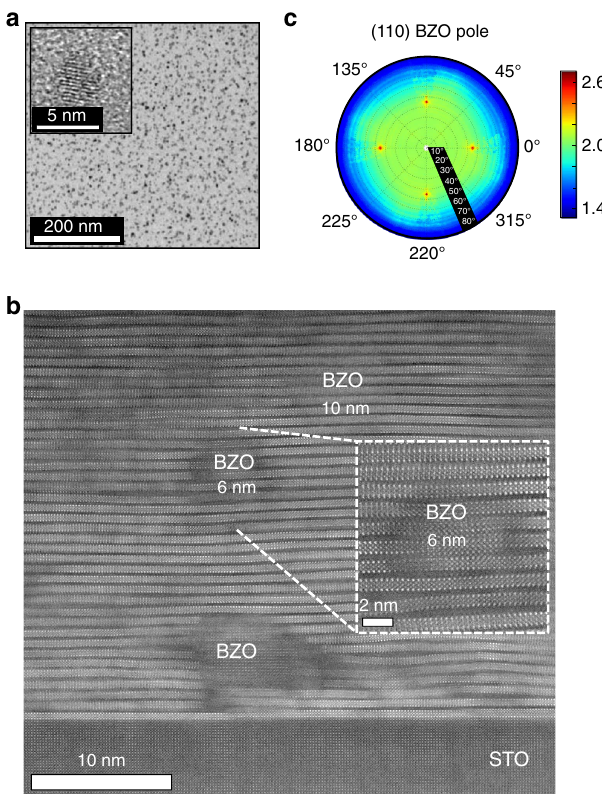
Fig. 5 Growth of TLAG nanocomposites. a TEM image of 5 nm BaHfO 3 nanoparticles in the colloidal solution. b STEM image of a 12% Molar BaZrO 3 (BZO) nanocomposite (in a 90 nm thick YBCO layer) on SrTiO 3 single crystal substrate, where few BZO nanoparticles are identi fi ed. The inset shows a high resolution image of the region with a 6 nm BZO nanoparticle embedded in the YBCO matrix; strong lattice distortions and Y248 intergrowth generated are evidenced. c (110) Pole fi gure of the 24% molar BZO nanocomposite where epitaxial orientation of the nanoparticles is demonstrated (data are fourfold symmetrized, XRD analysis performed at SOLEIL